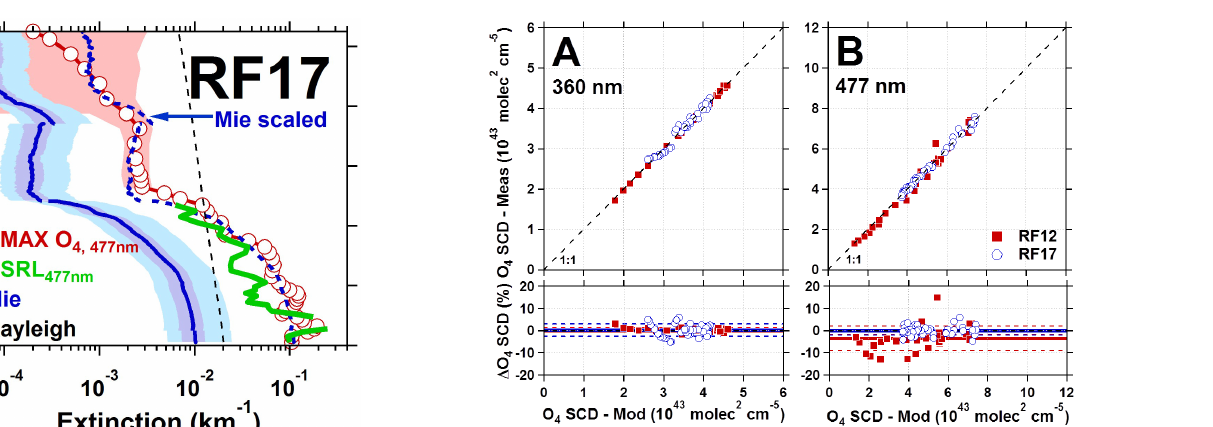
Figure 3. Comparison of aerosol extinction inferred from AMAX- O 4 measured at 477nm and Mie calculations constrained by aerosol size distribution measurements on the GV. The blue and red shading indicates the uncertainties in the Mie and O 4 -inferred extinction. See Sects. 2.1.3, 2.2 and 3.1 for details.